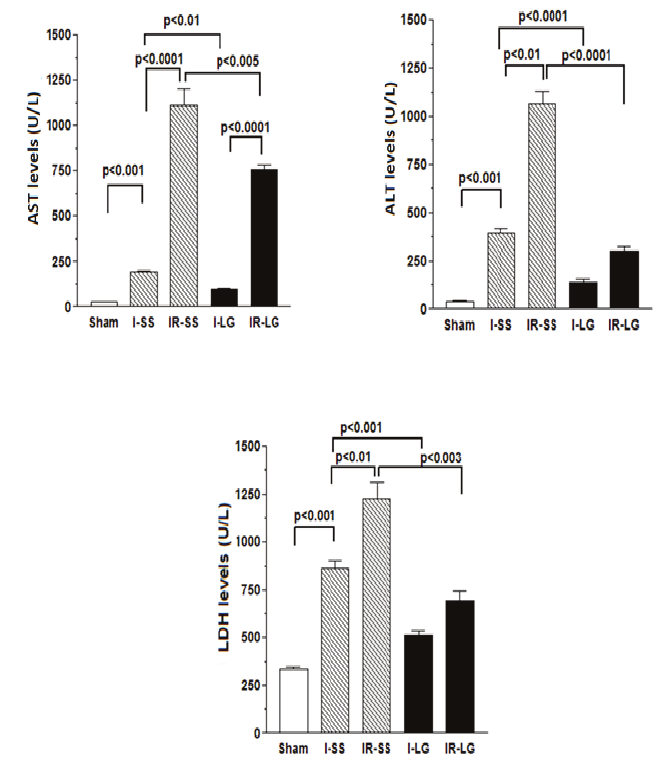
FIGURE 3 - The means±sd values (U/L) of aspartate aminotransferase (AST), in I-SS (194 ± 4), IR-SS (1110 ± 93), I-LG (92 ± 11) and IR- LG (758 ± 21); alanine aminotranferase (ALT) in I-SS (858 ± 41), IR-SS (1227 ± 82), I-LG (511 ± 26) and IR-LG (691 ± 54); lactate dehydrogenase (LDH) in I-SS (858 ± 41), IR-SS (1227 ± 82), I-LG (511 ± 26) and IR-LG (691 ± 54). ANOVA followed by Tukey Test